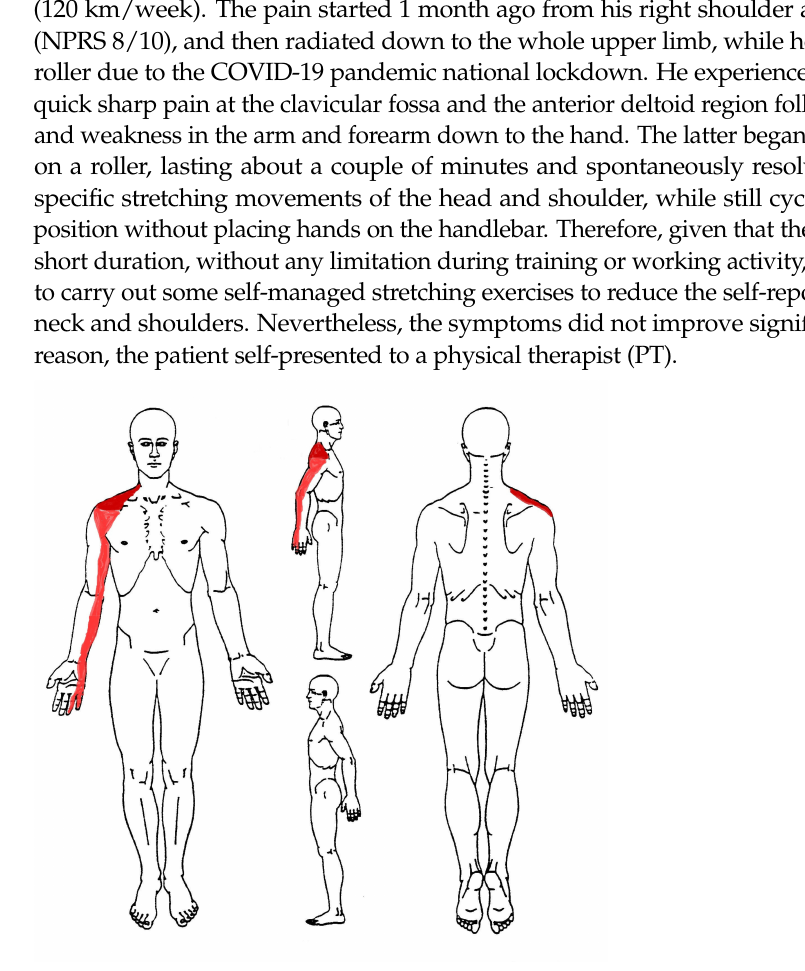
Figure 1. Body Chart. Bright red indicates the most painful body areas; pale red indicates the mild painful body